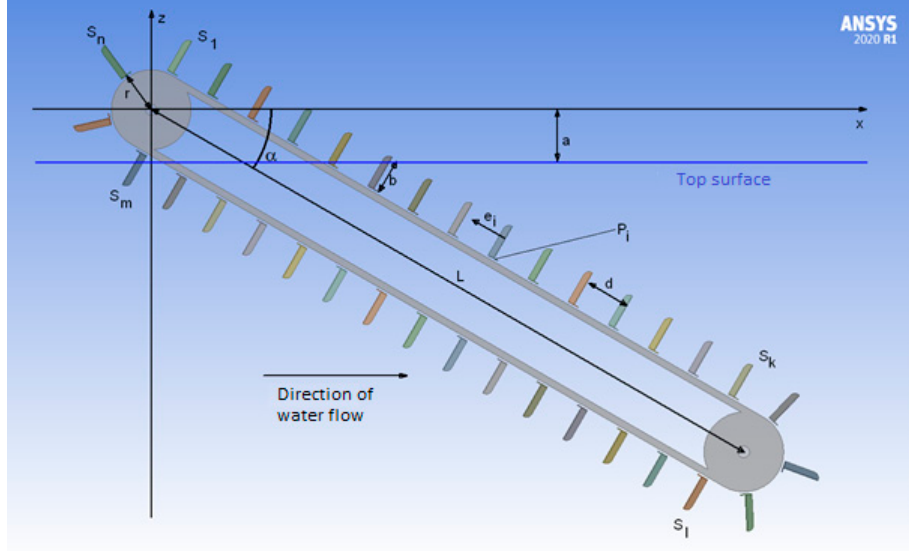
Figure 3. ECB with dimensions for the case where n = 35, α = 30°, L = 3 m, r = 175 mm, and b = 160 mm.